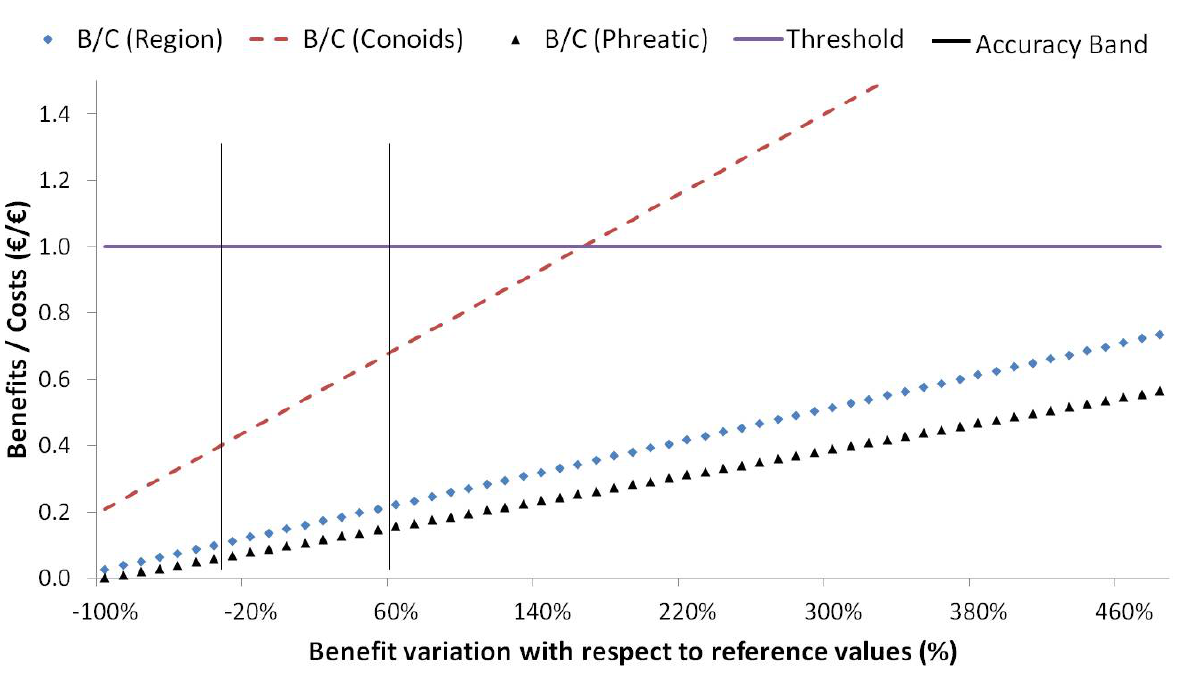
Figure 4. Benefit and cost ratio trend on the benefit variation with respect to reference